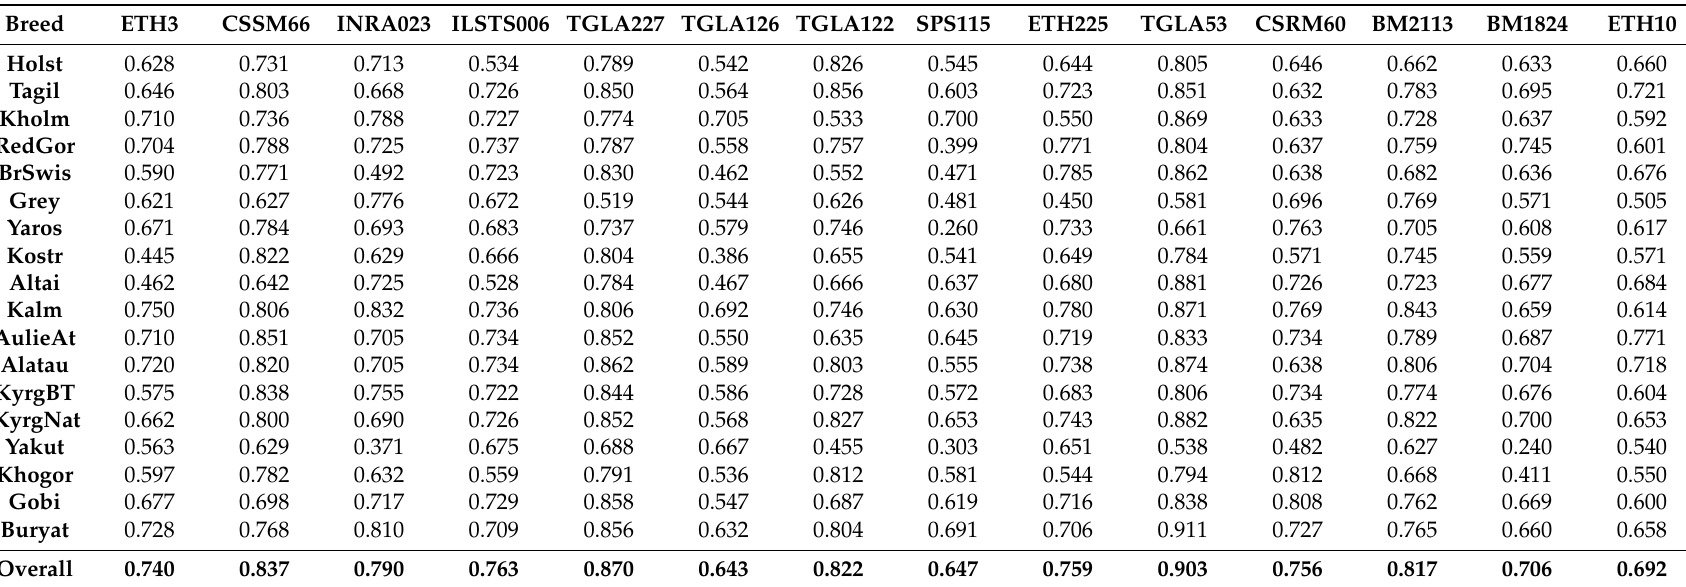
Table A3. The polymorphism information content values for each combination of sample and